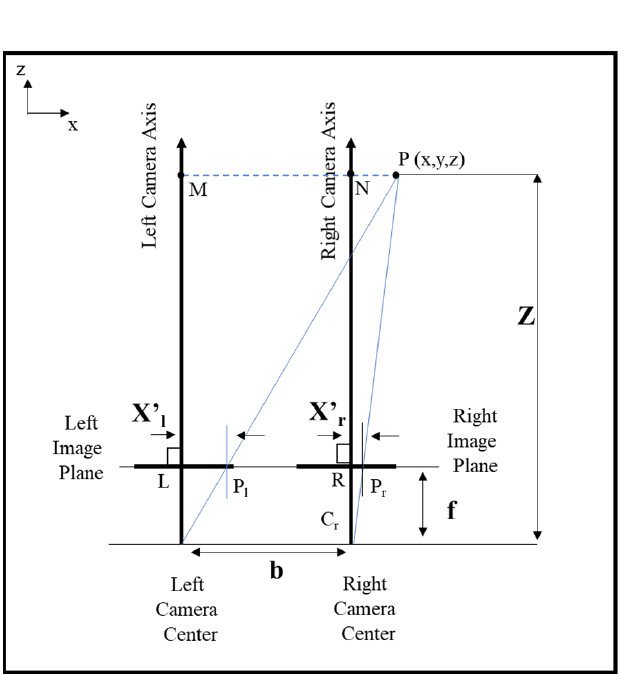
Figure 3. The above plot illustrates how projections of a 3D-point on the x-axis of the stereo-image is used to estimate real-world coordinates. P is a 3-D world point with coordinates (x, y, z). C l and C r represent the left and right cameras. L and R are the principal points (origin) of the left and right cameras, respectively. z l and z r are the z-axes that are normal to the image plane of the two cameras. P l and P r are the projections of the point P on the x -axis of the images in the left and right cameras, respectively. X’ l is the distance between the principal point L and the projection point P l . Similarly, X’ r is the distance between the principal point R and the projection point P r . M and N are the projections of P on z l and z r , respectively. f is the focal length, and b is the baseline distance of the stereo camera. X’ l and X’ r are used to estimate the disparity between the projections of point P on the left and right image planes. Finally f, b, and disparity are used together to obtain the real-world depth z of the point.